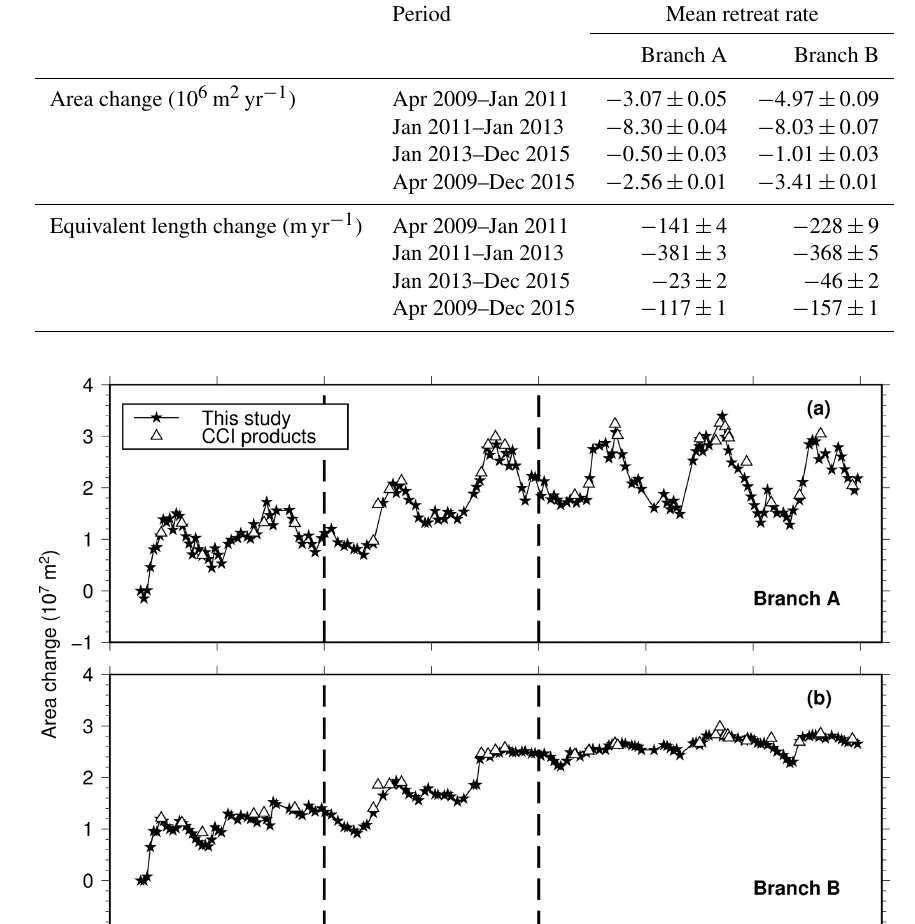
Table 1. Retreat rates in area and equivalent length during different phases.